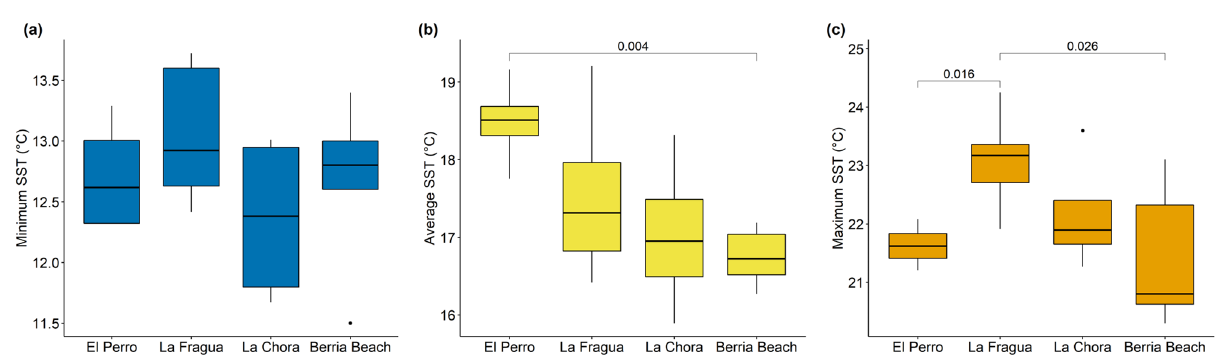
Figure 5. Sea surface temperature (SST) reconstruction using M. galloprovincialis shells from the three archaeological sites using δ 18 O s as palaeothermometer. Reconstructed ( a ) minimum, ( b ) average and ( c ) maximum water temperatures. Shells collected from Berria Beach and previously analysed by Milano et al. 23 were used as modern comparison. Significant differences (p < 0.05) are given in the graphs. Black circles identify the outliers, data points laying outside 1.5 times the interquartile range (defined by box Mussels from the open coast were collected mainly in winter (60%) and at a lesser degree during the other three seasons (40% in spring and 20% in summer and autumn; Fig. 3). The one coastal specimen collected in autumn belonged to unit 1.4, representing therefore a different collection event than the rest of the shells, from unit 1.1 (Fig. 4). Likewise, in the lower estuarine habitat, shellfish gathering occurred mainly during winter and autumn (50% and 25%, respectively) but also in summer (25%). Here, half of the specimens, collected in autumn and winter, were retrieved from unit 1.4 (Fig. 4). Collection in the upper estuary was recorded only in winter (Fig. 3). At La Chora, all the open coast mussels were harvested during winter and most of them were retrieved from unit 104 (Figs. 3, 4). Half of the mussels from lower estuarine habitats were harvested in winter and half in spring. Also, the shells from the upper estuary were collected during autumn and winter (40% and 60%, respectively). Palaeotemperature reconstruction. The SSTs recorded by the M. galloprovincialis specimens from El Perro ranged from 12.7 ± 0.5 to 21.6 ± 0.4 °C, with an average of 18.5 ± 0.6 °C (Fig. 5). When only shells harvested from the open coast were used in the calculation, the SSTs were ranging from 12.6 ± 0.6 to 21.8 ± 0.3 °C, with an average of 18.7 ± 0.4 °C. At La Fragua, the SSTs ranged from 13.1 ± 0.6 to 23.1 ± 0.9 °C, with an average of 17.5 ± 1.1 °C (Fig. 5). When only shells harvested from the open coast were used in the calculation, the SSTs were ranging from 13.3 ± 0.6 to 23.4 ± 0.8 °C, with an average of 18.2 ± 1.0 °C. The shells from La Chora recorded SSTs ranging from 12.4 ± 0.8 to 22.2 ± 1.0 °C, with an average of 17.0 ± 1.0 °C (Fig. 5). When only specimens harvested